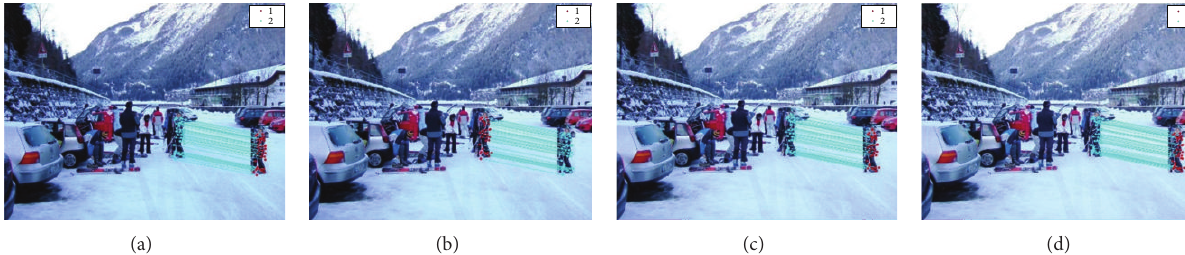
Figure 8: Copy paste detection results for: (a) gamma value = 1.2, (b) gamma value = 1.4, (c) gamma value = 1.6, and (d) gamma value = 1.8.